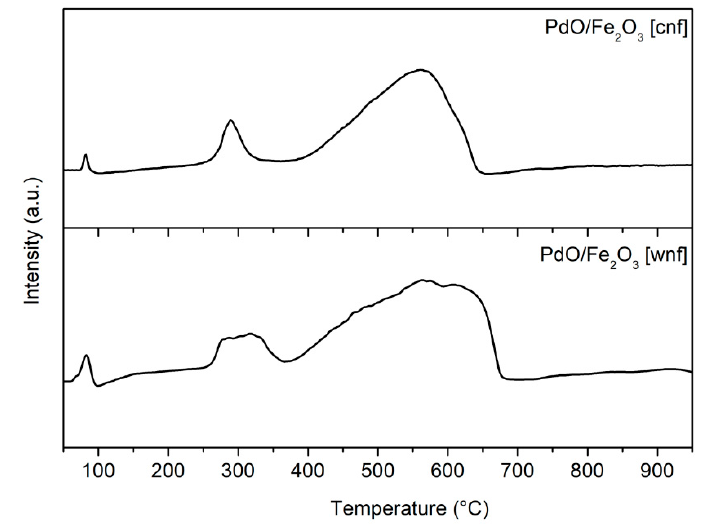
Figure 3. The H 2 -TPR profiles of PdO/Fe 2 O 3 [wnf] and PdO/Fe 2 O 3 [cnf] samples.